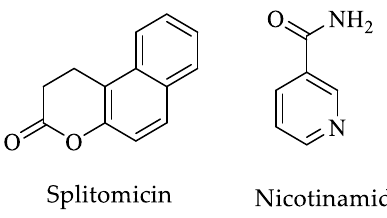
Figure 13. Sir2 inhibitors as antiamoebic agents.